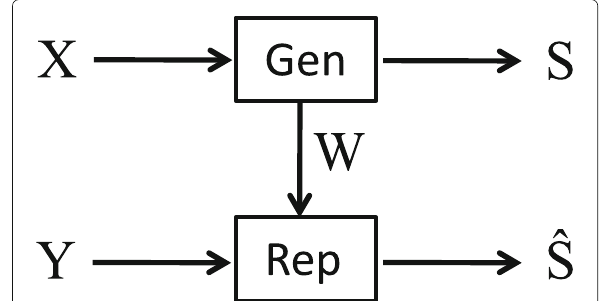
Fig. 1 Data flow in a generic Helper Data